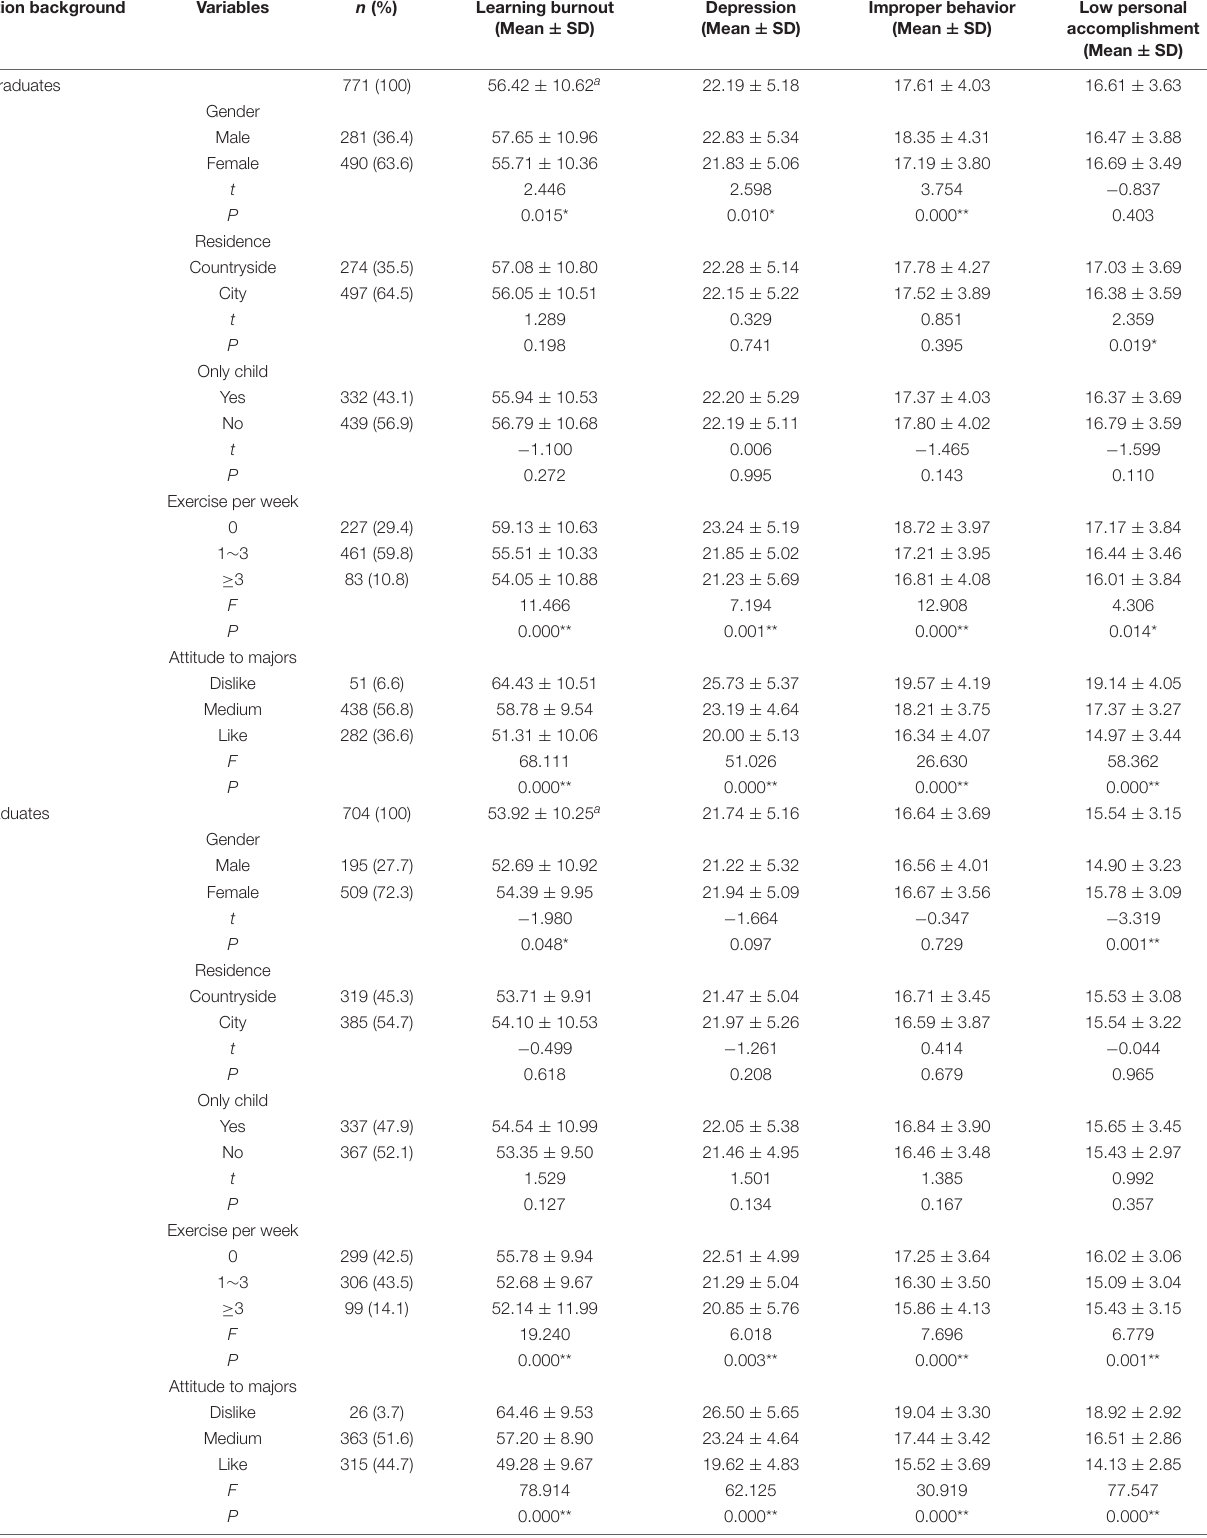
TABLE 1 | Demographic characteristics and comparisons on learning burnout and its three dimensions among undergraduates and postgraduates. Education